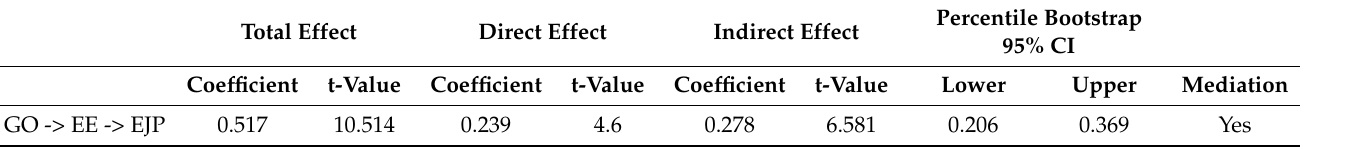
Table 6. Results of